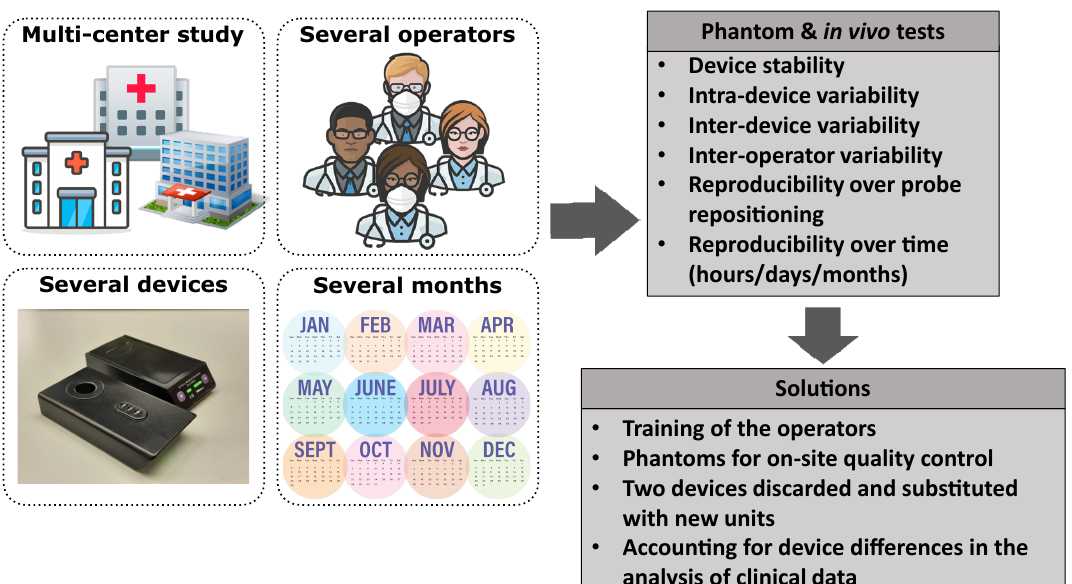
Figure 1. A schematic summary of the challenges of a multi-center clinical study and the actions taken to address them. Icons taken from